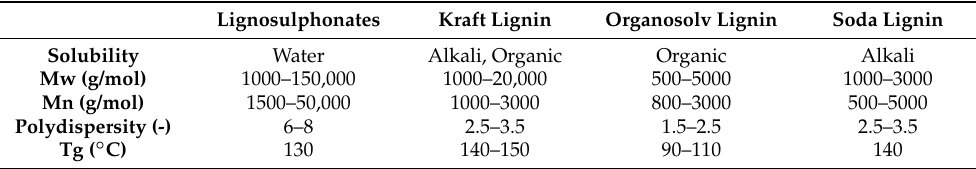
Table 2. Selected properties of isolated lignin.